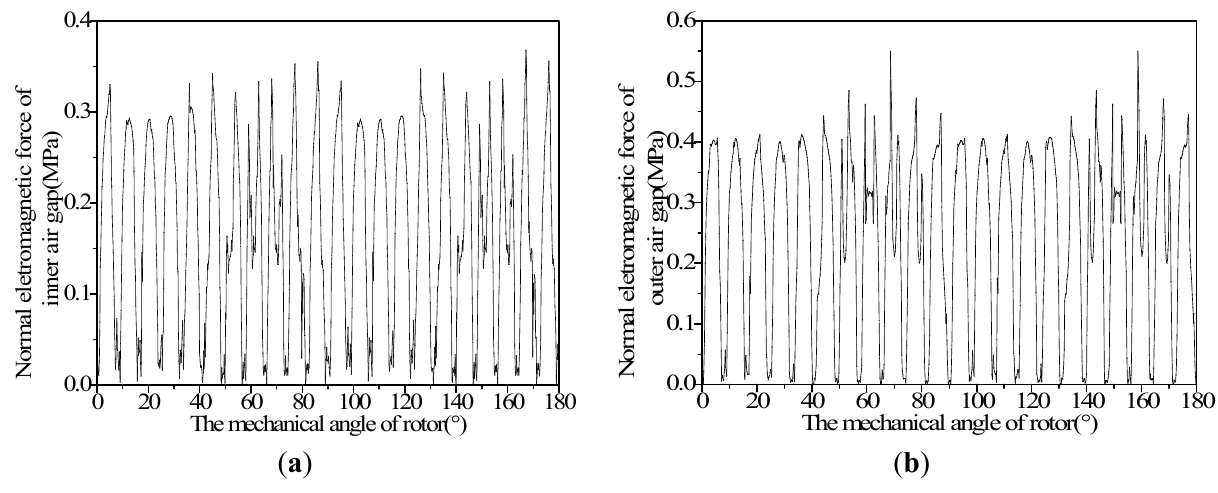
Figure 16. The normal electromagnetic force density of 1 kW DRPMSM: ( a ) inner air gap; and ( b ) outer air gap.